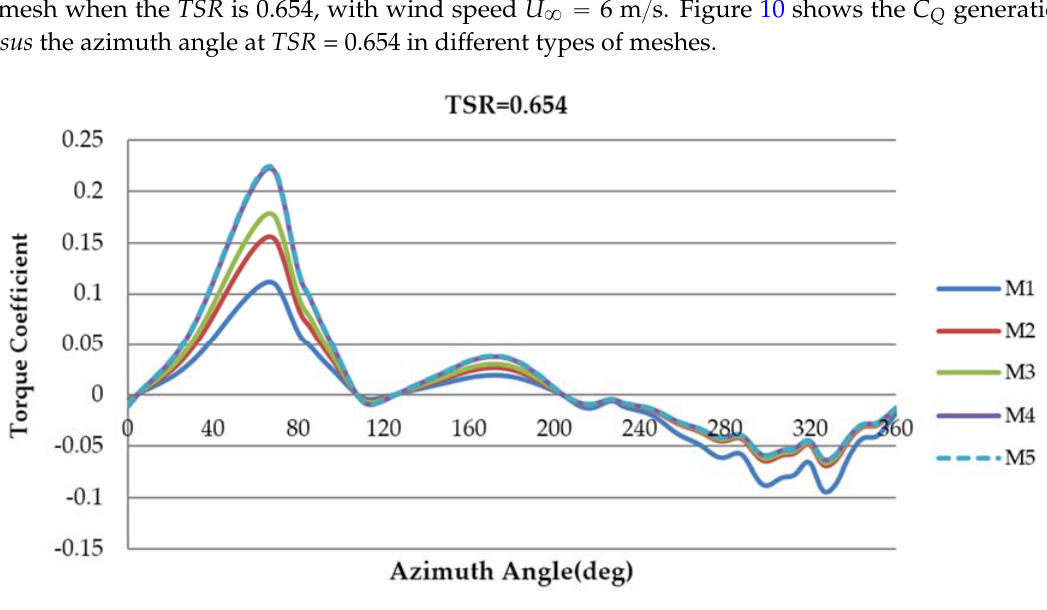
Figure 10. Mesh dependency test in TSR = 0.654.